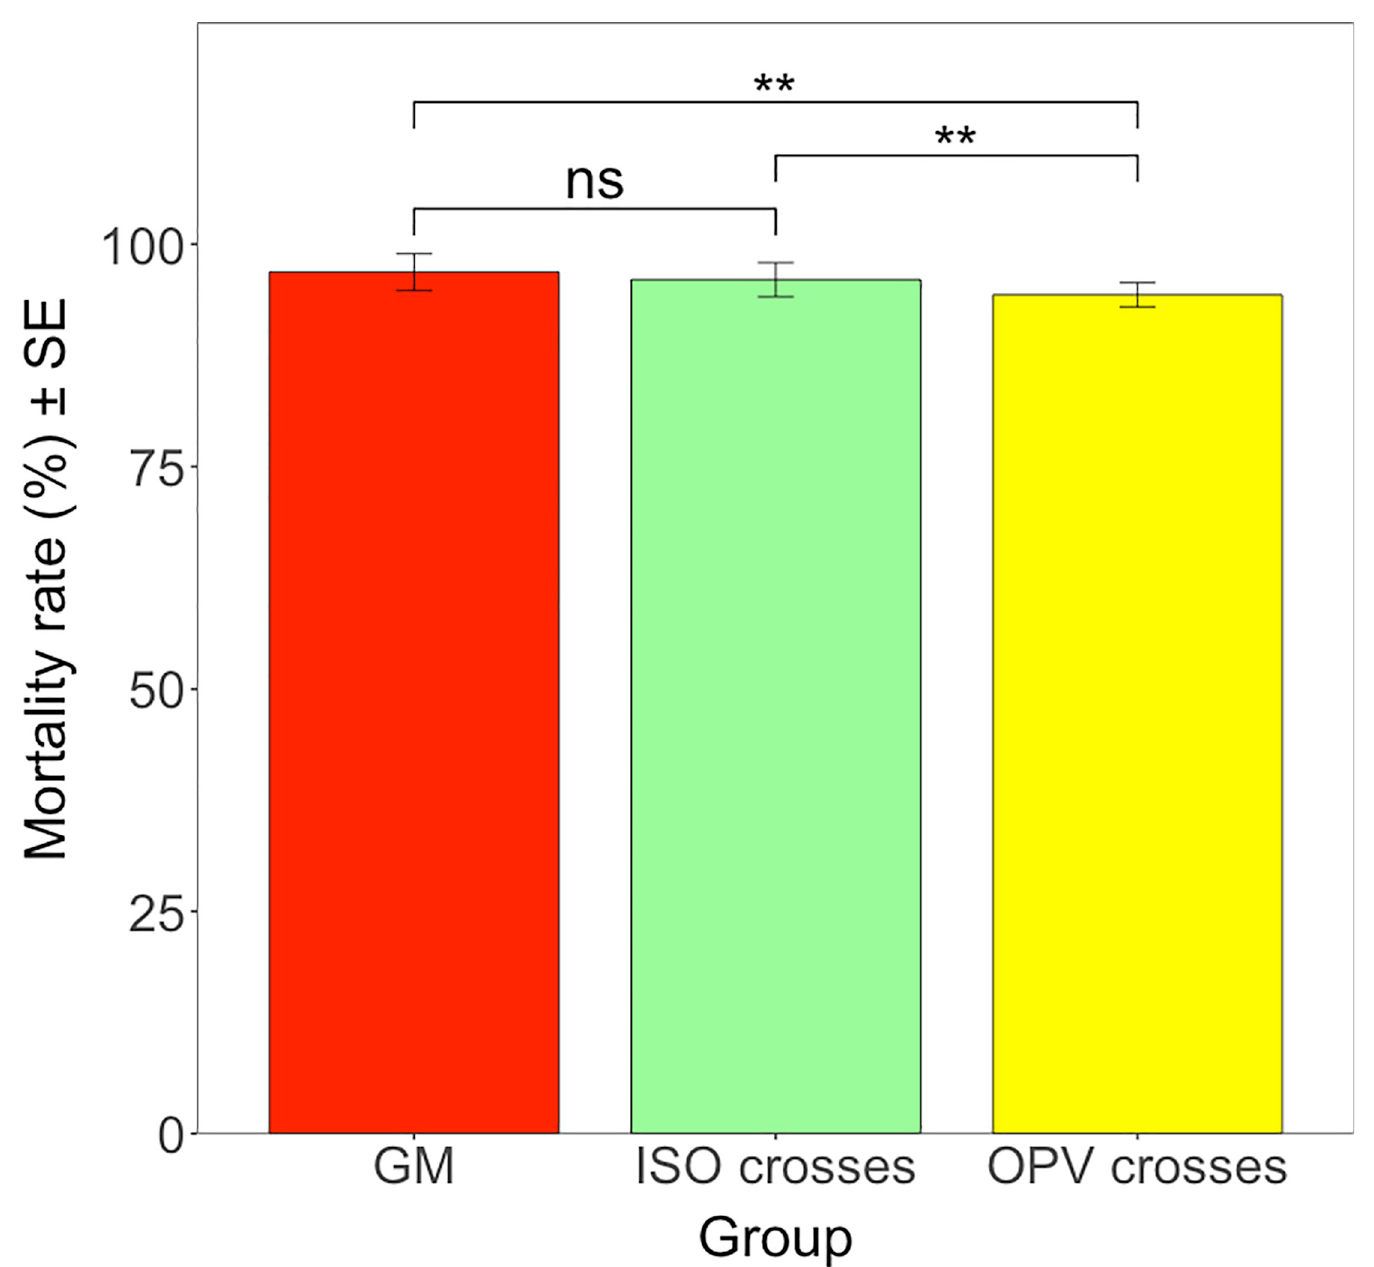
Fig 8. Mean mortality rate (%) of H . armigera in different groups from Brazil. Vertical bars show mean values, with standard error ( ± SE) indicated as lines. Results of pairwise comparisons between the different groups. �� P < 0.01, ns = not significant. The p-values were adjusted by the Tukey comparison method.